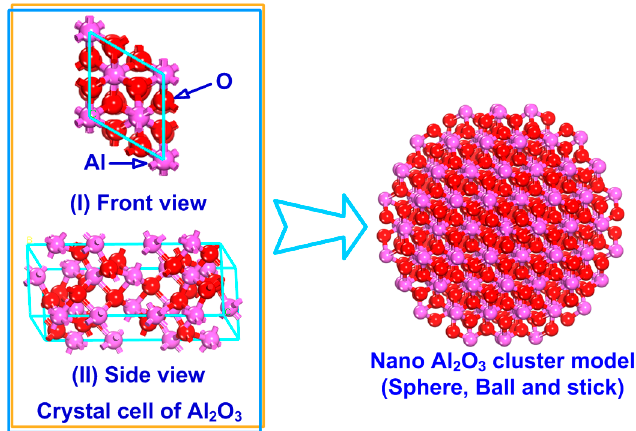
Figure 9. Molecular structure of nano-Al 2 O 3 .